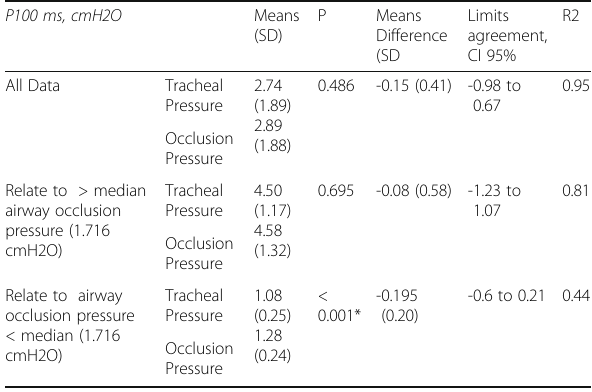
Table 1 (abstract 000782). Agreement of the measurements of P100 between both